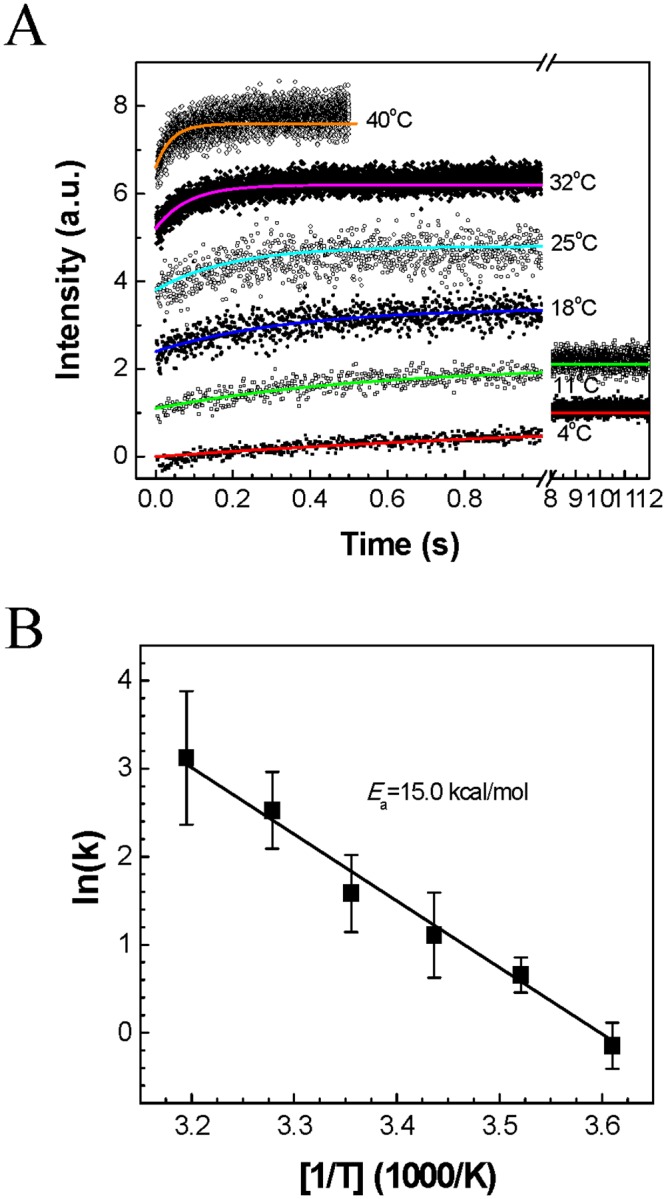
Temperature dependence of the osmotic response of inactivated influenza virus.The kinetics of osmotic water transport through the viral envelope were investigated at several temperatures while applying a hyperosmotic difference of ΔCos = 304 mOsm with trehalose. (A) Scattered light intensities and fitted curves and (B) Arrhenius plot for water transport across the viral membranes (mean ± SD, n = 8–20). The Arrhenius activation energy was calculated from the linear regression of the ln(k) vs. 1/T plot.